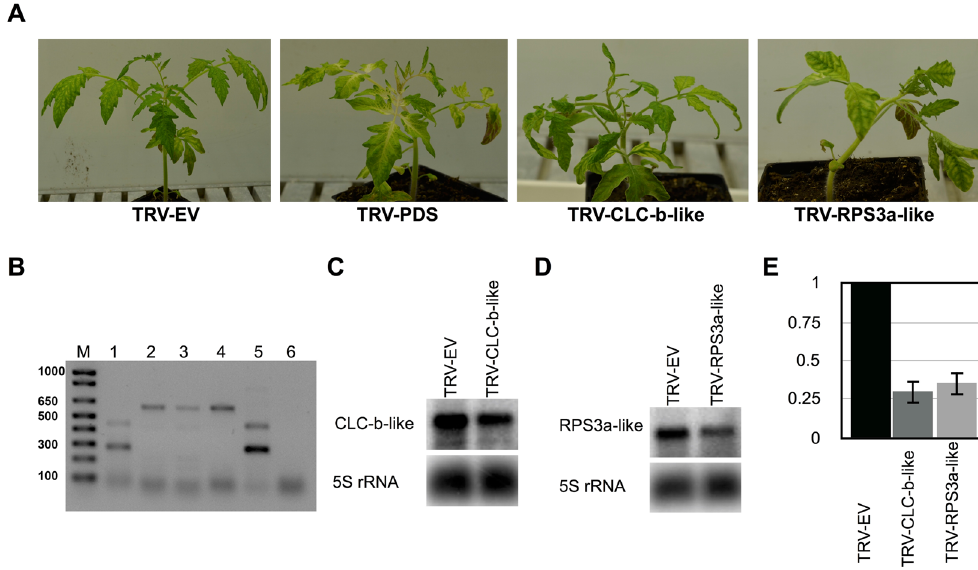
Figure 2. Effect of chloride channel protein CLC-b-like mRNA and the 40S ribosomal protein S3a-like mRNA on the plant’s morphology. ( A ) The tomato plants were subjected to a knock-down assay by a VIGS technique using the TRV1 vector in combination with either the TRV2 empty vector, or with its derivatives. After 18- days post infiltration plants exhibited phenotypic alterations similar to viroid infection. TRV-EV, TRV empty vector inoculated plants; TRV-PDS, plants inoculated with pTRV2:PDS; TRV-CLC-b-like, the plant infiltrated with pTRV2:CLC-b-like; and, TRV-RPS3a, the plant infiltrated with pTRV2:RPS3a. ( B ) The total nucleic acids extracted from these plants were PCR analyzed for the systemic presence of TRV2 derivatives. Lane M, 1 kb plus molecular marker, Lane 1, TRV-EV; Lane 2, pTRV2:PDS; Lane 3, TRV-CLC-b-like; Lane 4, TRV-RPS3a; Lane 5, PCR positive control for the TRV-EV vector; and, lane 6, PCR negative control. Total RNA extracted samples from the agroinfitrated plants were analyzed by gel blot assay for the knock-down/suppression of ( C ) Chloride channel CLC-b- like and, ( D ) RPS3a -like mRNAs using gene specific radiolabeled probes. The 5 S rRNA was used as a loading control. Full size gel blots are presented in Fig. S1. ( E ) The gel blot signals from ( C ) and ( D ) were quantified and expressed as a ratio of the target mRNA to the 5S rRNA signals. For each set of experiments, the ratio of target mRNA to 5S rRNA obtained with TRV-EV (control) was set at a value of 1. The additional bars indicate the relative target mRNA/5S rRNA ratio for each TRV-derivate vector (as indicated) expressed. Each experiment was performed at least three times. Error bars indicate